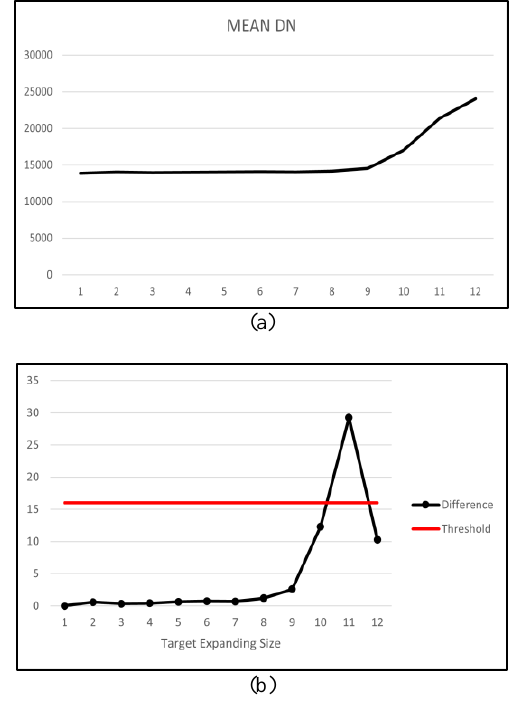
Figure 6. Example of semi-automatic target detect result. (a) Example of mean DN value with expanding detection size. (b) Example of Difference value with expanding detection size.